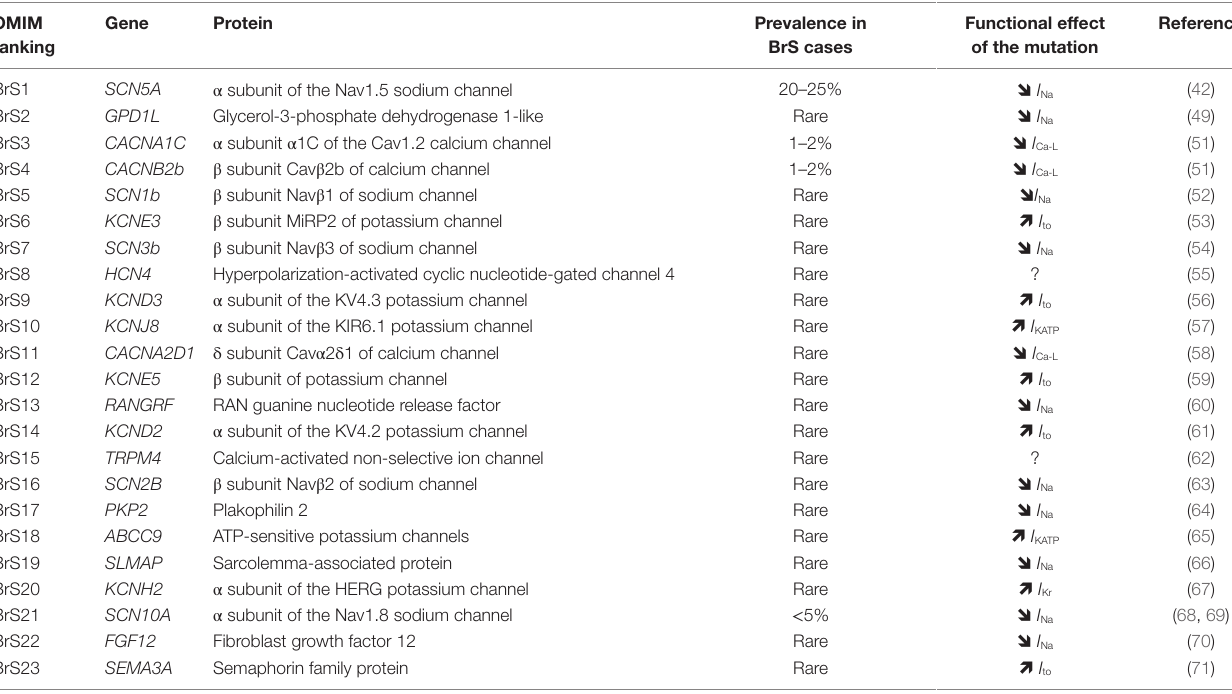
TABLe 1 | The 23 reported susceptibility genes for